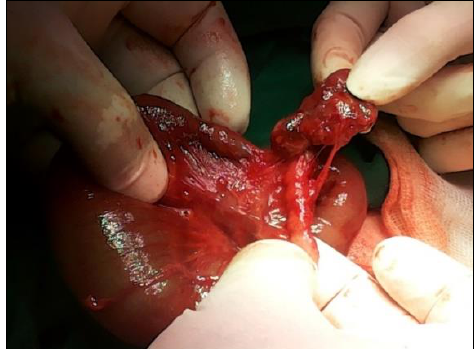
Figure 1. Intra-operative photograph confirming a type I jejunal atresia.